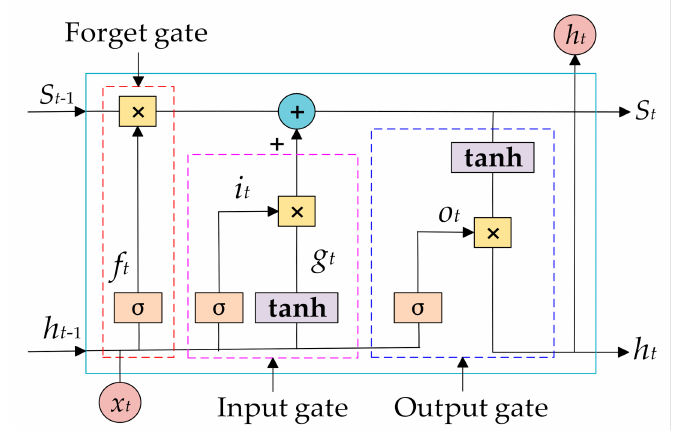
Figure 7. Basic unit of LSTM